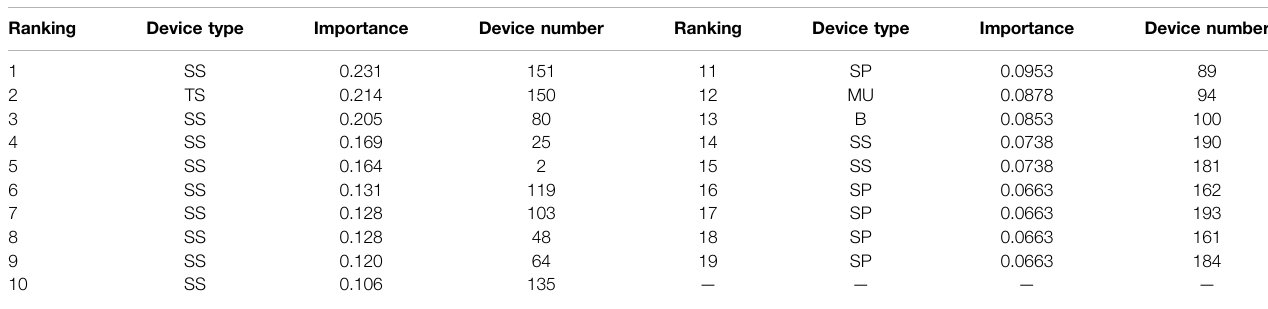
TABLE 2 | List of the top 19 devices in importance.